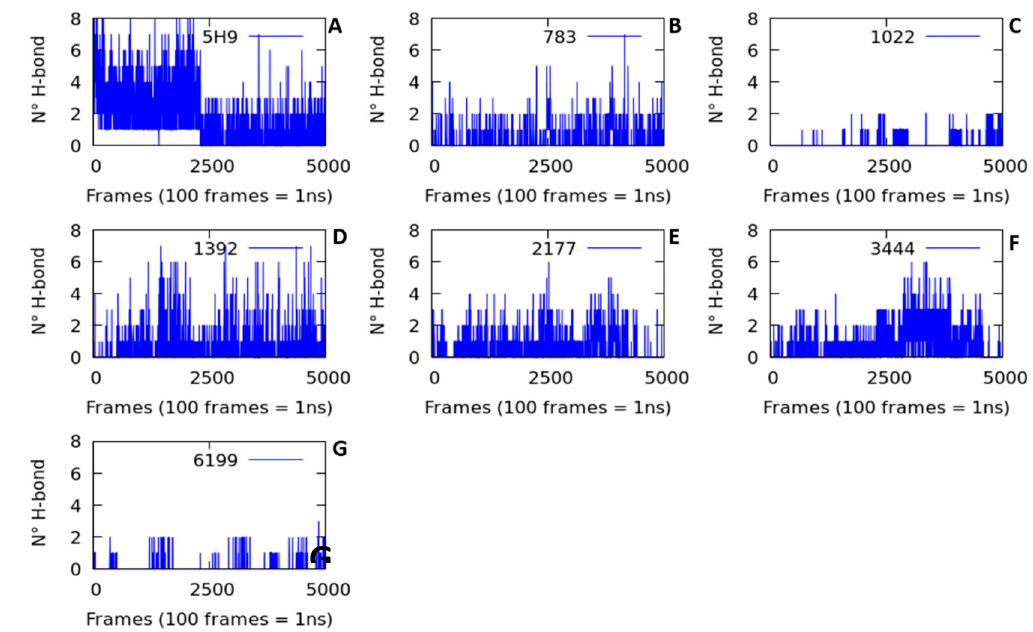
Figure 5. The number of hydrogen bonds between the thermolysin and the ligands designed in silico during 50 ns of molecular dynamics simulation. ( A ) Lig5H9 reference compound, ( B ) Lig783, ( C ) Lig1022, ( D ) Lig1392, ( E ) Lig2177, ( F ) Lig3444, and ( G ) Lig-6199.